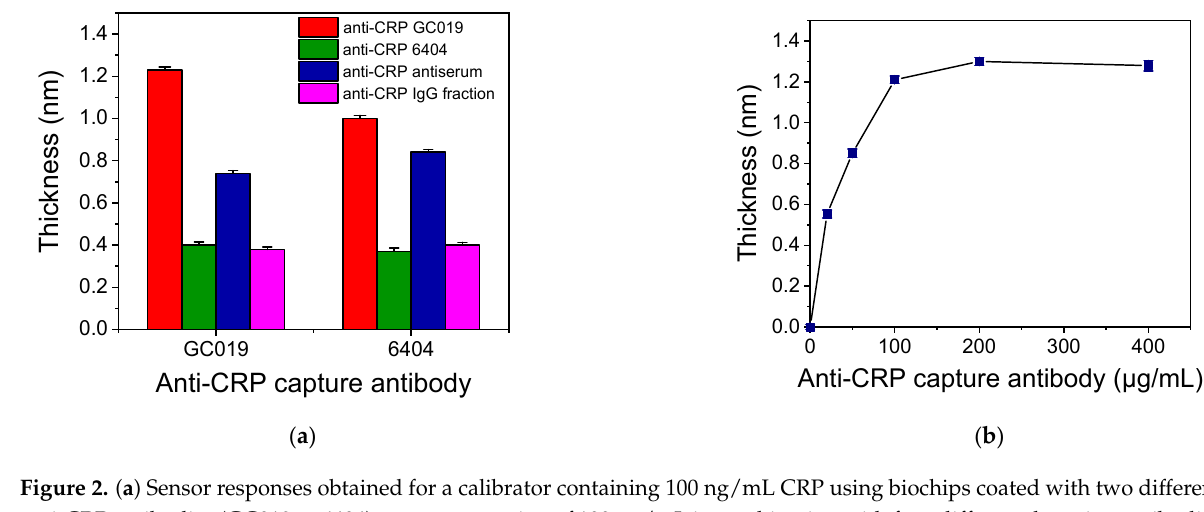
6 of 14 Figure 1. ( a ) Depiction of the main part of the instrument. ( b ) Images of the: (i) whole instrument and accompanying PC, (ii) fluidic module, and (iii) docking station. ( c ) Depiction of the PC screen at the end of a run. ( d ) Schematic of the chip, sensing principle and two-site sandwich immunoassay procedure. 3. Results 3.1. Assay Development and Optimization The detection of CRP in human plasma using the proposed WLRS device is based on a label-free two-site sandwich immunoassay. As it is schematically depicted in Figure 1d, the assay involved two steps, the first one being the reaction of the CRP molecules in cal-